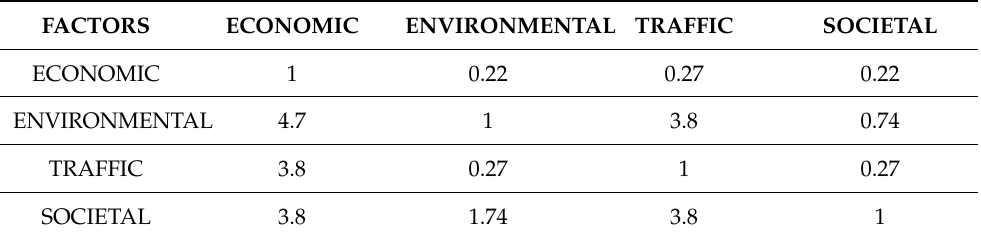
Table 6. Representation of preference of factors in defuzzified form using Equation (18).